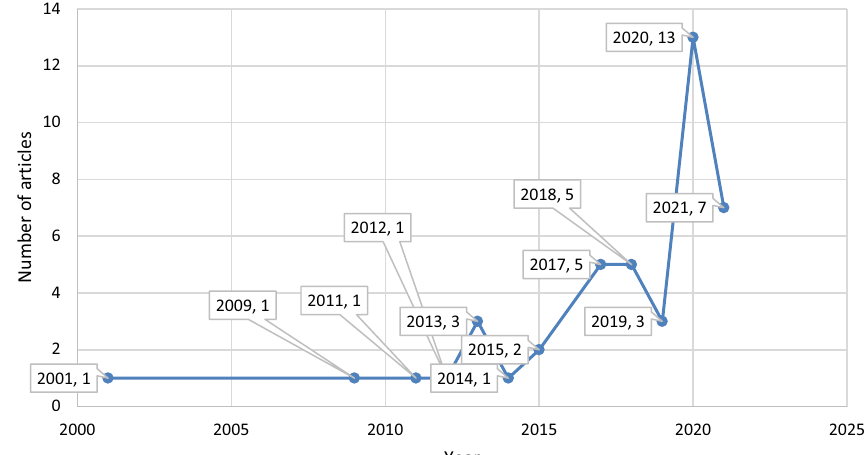
Fig. 1 Yearly distribution of digital literacy related papers